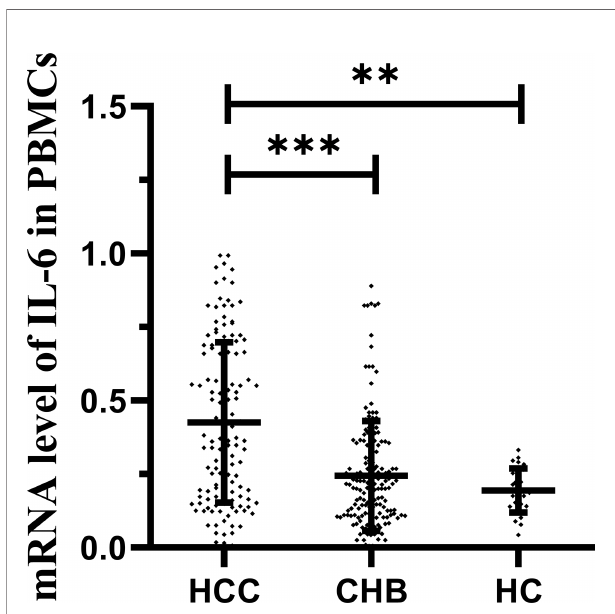
FIGURE 3 | IL-6 mRNA levels in patients with HBV-associated HCC, CHB and HCs. IL-6 mRNA level was signi fi cantly higher in the HCC group than in the CHB (p < 0.001) and HCs (P = 0.001). ***p < 0.001, **p < 0.01.